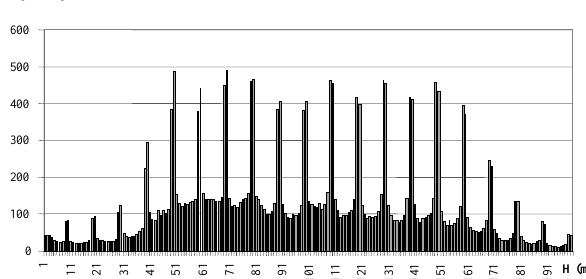
Fig 3. Histogram of digital terrain model, created from height contour lines horizontali ų , esti laiptuotas. Tai matyti iš SRM paviršiaus reikšmi ų histogramos (3 pav.).